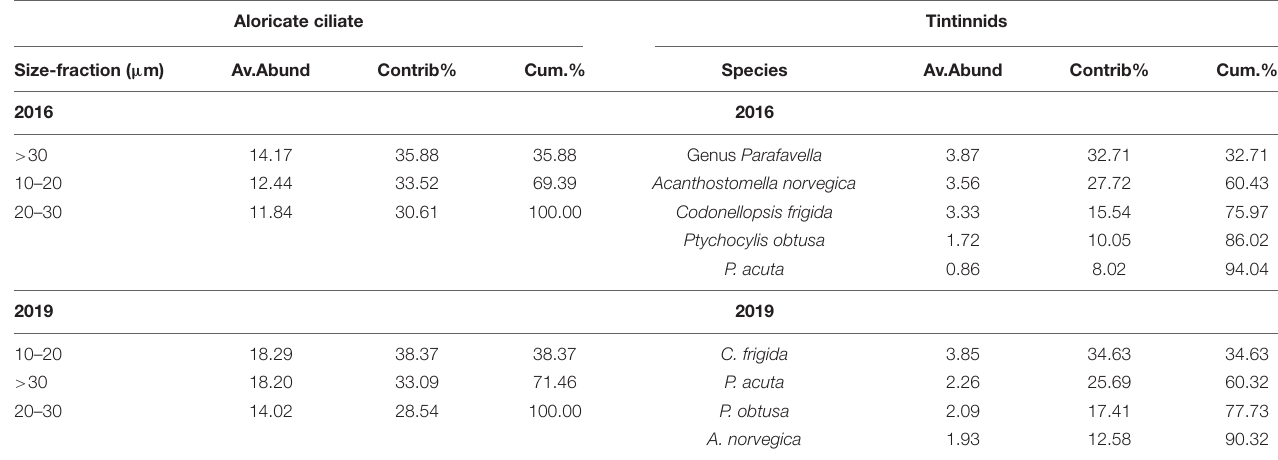
TABLE 4 | Results from SIMPER analysis based on Bray Curtis similarity showing community composition of aloricate ciliate and tintinnid whose cumulative contribution rate was higher than 90% in 2016 and 2019, respectively. Aloricate ciliate